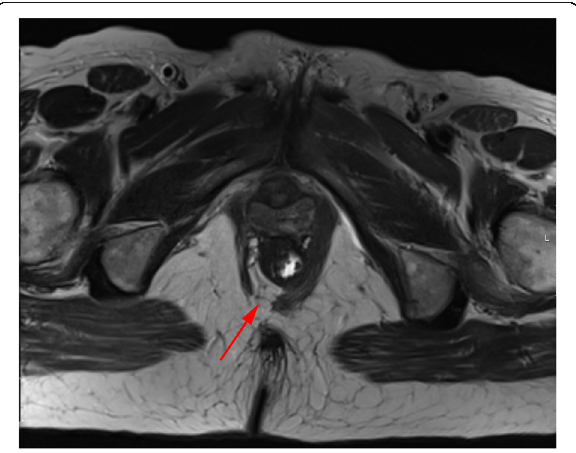
Fig. 19 Puborectalis defect. Axial T2-TSE image of the puborectalis muscle, demonstrating a right posterior defect, asymmetry, and atrophy, with lipomatous involution (red arrow)